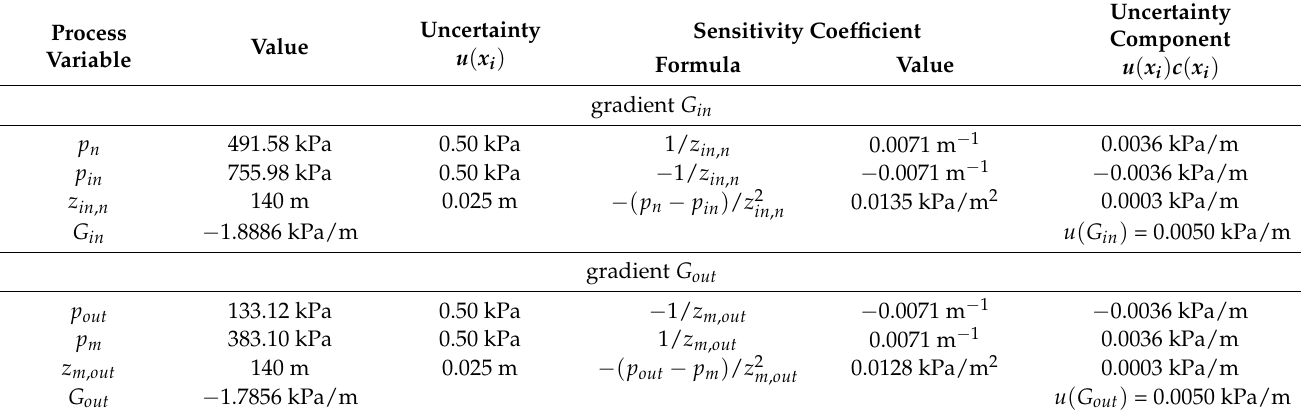
Table 5. Uncertainty budget for G in and G out gradients determination.